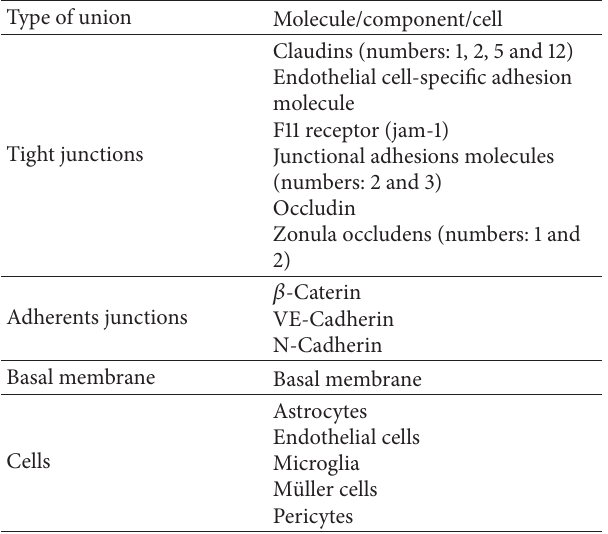
Table 1: Blood-retina barrier components, types of union, and the molecules located in retinal endothelial